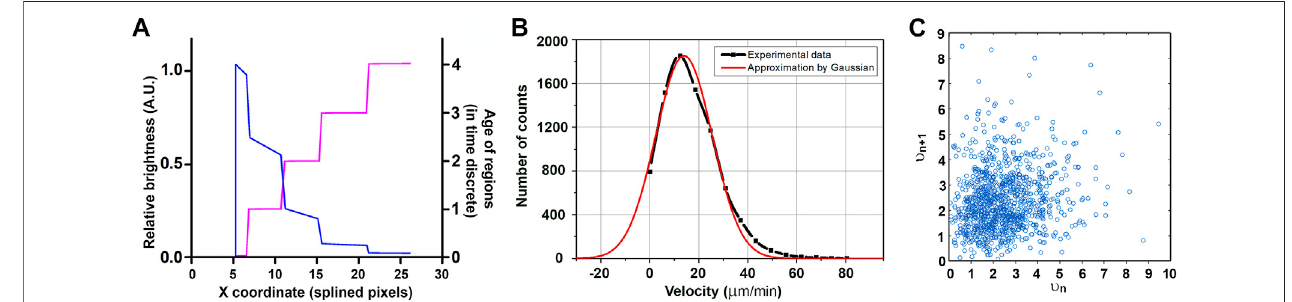
FIGURE 6 | EB-3 intensity by piecewise approximation. The older the ROI, the lower is the signal in it. A signal is recorded intermittently, and piecewise approximationrepresentstheexpectedintensitydistributionwithinthecometiftheaf fi nityoftheMTtoEB-3decreasesexponentiallywithtime(blueline) (A) .The “ age ” of regionsdependedonthexcoordinateforthemicrotubule(purpleline). (B) .MTvelocityhistogramforHT1080cellsapproximatedbyGaussiandistribution. Y -axis:comet counts. µ (cid:1) 13.9 µm/min; σ (cid:1) 16.3 µm/min; R 2 > 0.98. (C) Lack of correlation between growth velocities (given in A.U.) in subsequent time periods ( v n versus v n+1